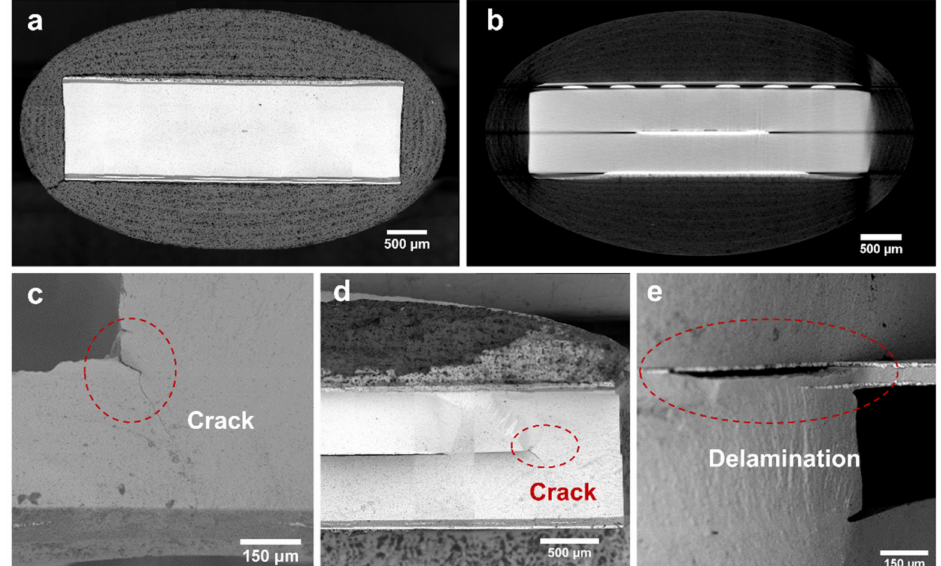
Figure 7. Micromorphology of nitrogen–oxygen sensors including SEM images ( a ) and X-ray micro CT image ( b ) of a cross-sectional view; cracks at the right-angle position of the air chamber ( c , d ); delamination position between the Al 2 O 3 layer and the ZrO 2 layer ( e